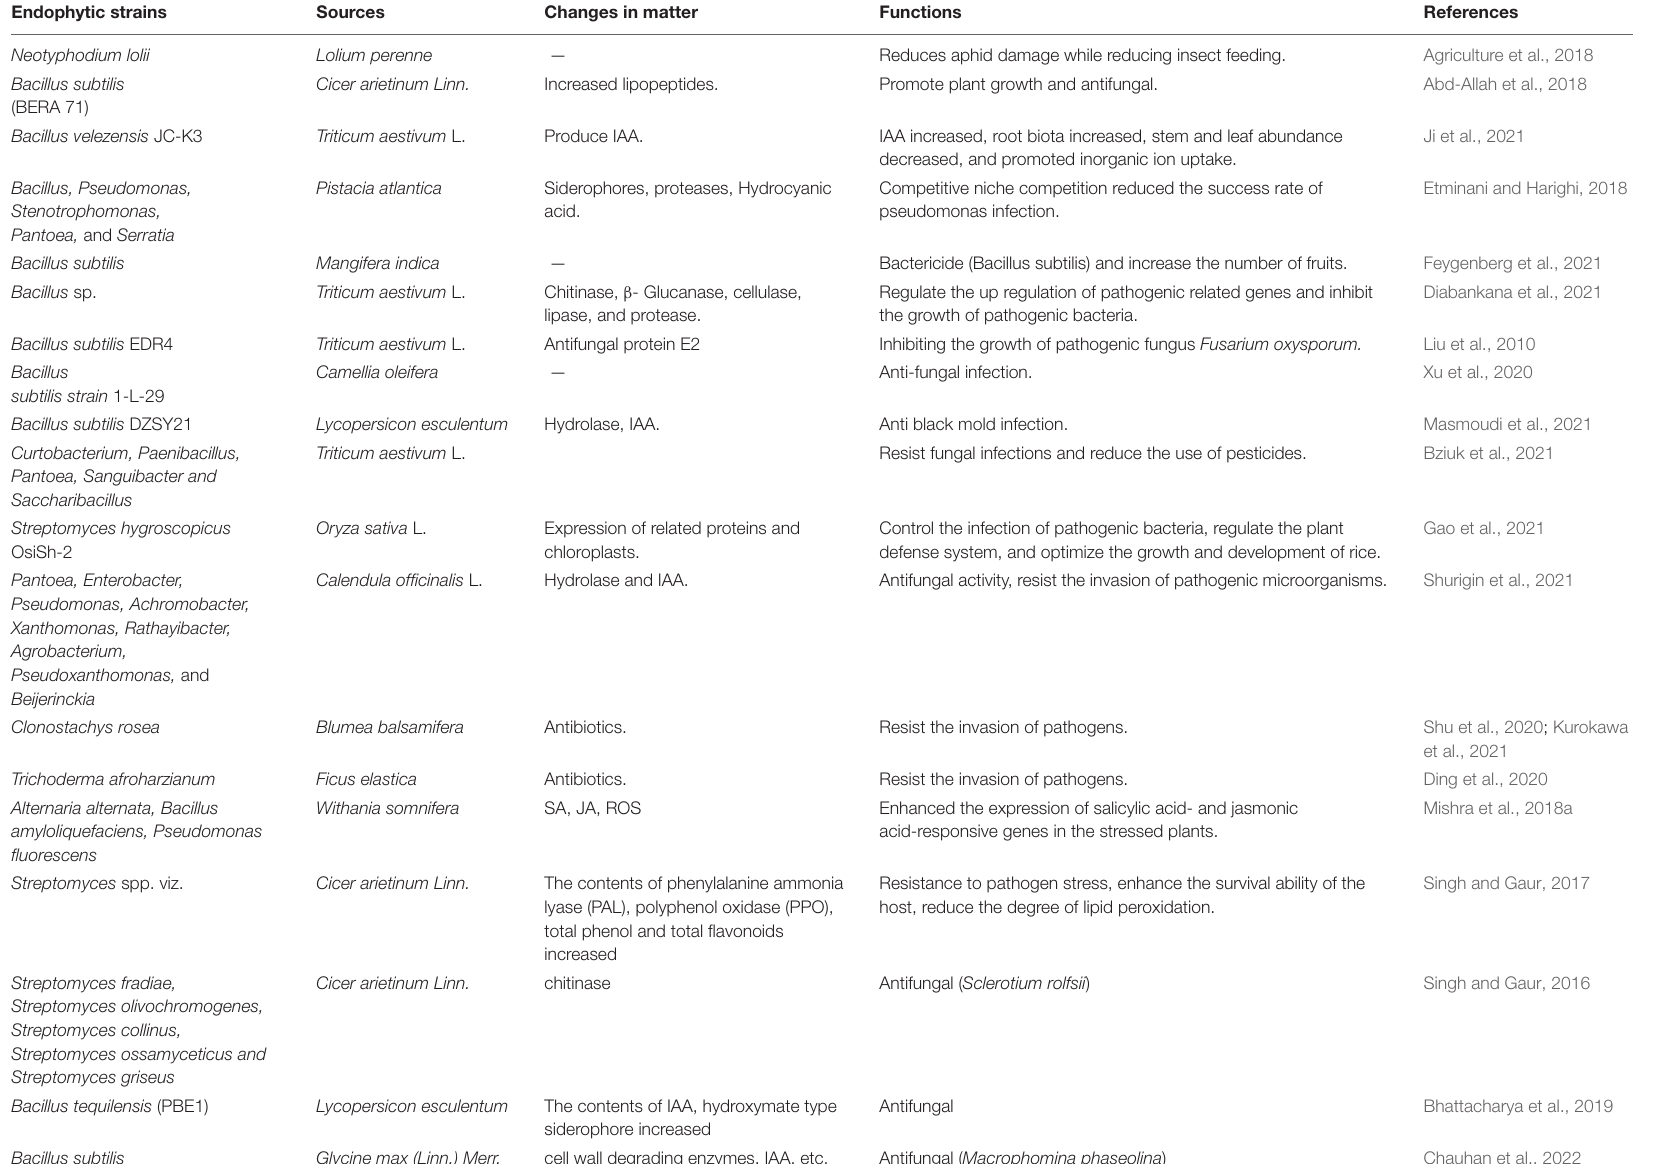
TABLE 3 | Effect of endophytes on host biotic stress